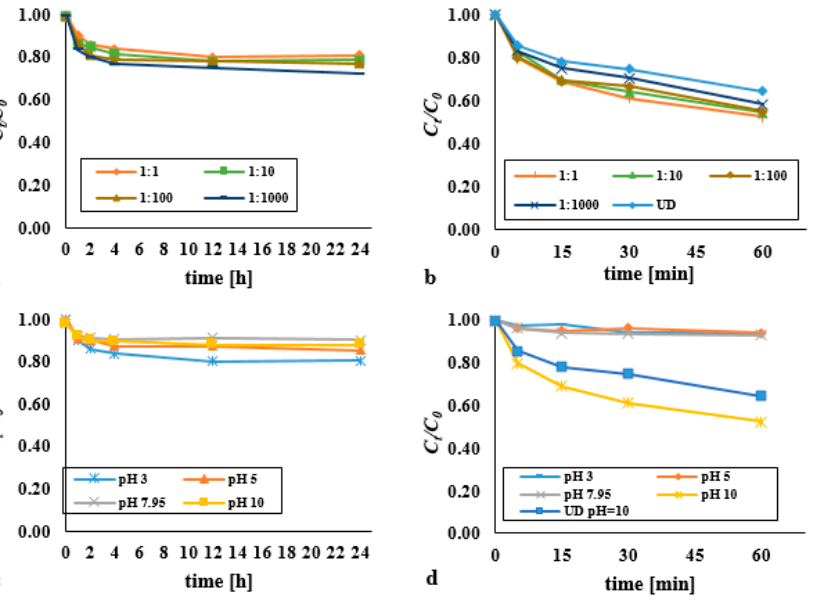
Figure 1. Impact on the decomposition of DEHP exerted using ( a ) hydrogen peroxide in various doses (pH = 3); ( b ) hydrogen peroxide in various doses supported by an ultrasonic field (pH = 10, acoustic wave intensity - 3.97 W/cm 2 ); ( c ) hydrogen peroxide in various pH (molar ratio DEHP:H 2 O 2 1:1); ( d ) hydrogen peroxide supported by an ultrasonic field in various pH (molar ratio DEHP:H 2 O 2 1:1, acoustic wave intensity — 3.97 W/cm 2 ).